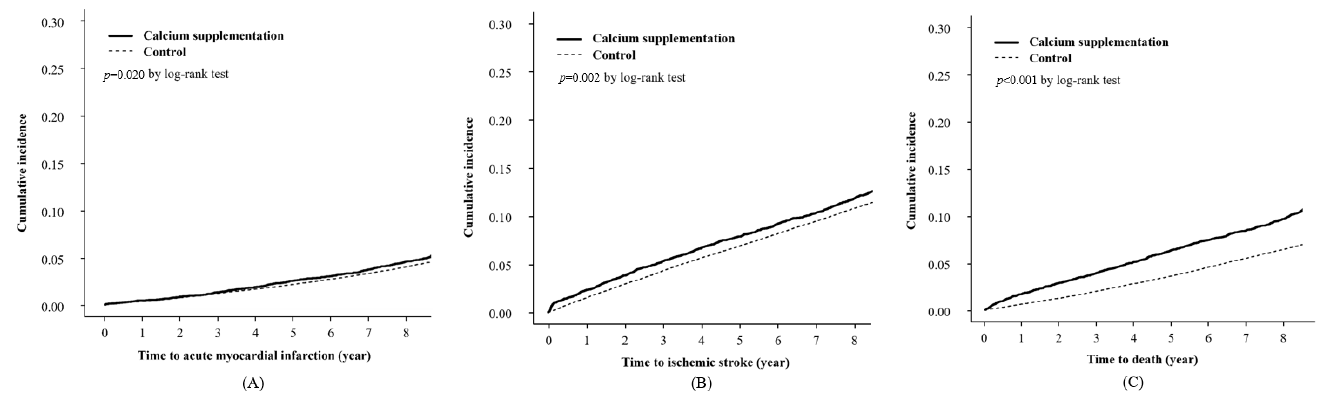
Figure 2. Kaplan–Meier curves with the cumulative incidence of acute myocardial infarction ( A ), ischemic stroke ( B ), and death events ( C ) following the prescription of calcium supplements.